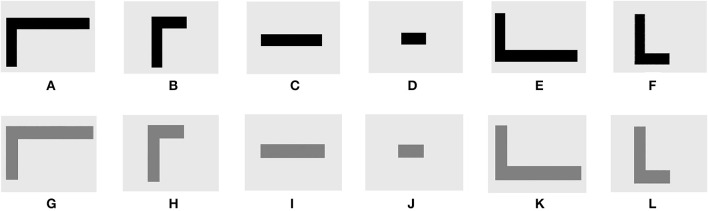
Symbols that correspond to the 12 trained tones. Symbol-to-tone correspondences include (A)
High long black: high-pitched 1000 ms sine wave; (B)
High short black: high-pitched 400 ms sine wave; (C)
Mid long black: mid-pitched 1000 ms sine wave; (D)
Mid short black: mid-pitched 400 ms sine wave; (E)
Low long black: low-pitched 1000 ms sine wave; (F)
Low short black: low-pitched 400 ms sine wave; (G)
High long gray: high-pitched 1000 ms harmonic wave; (H)
High short gray: high-pitched 400 ms harmonic wave; (I)
Mid long gray: mid-pitched 1000 ms harmonic wave; (J)
Mid short gray: mid-pitched 400 ms harmonic wave; (K)
Low long gray: low-pitched 1000 ms harmonic wave; (L)
Low short gray: low-pitched 400 ms harmonic wave.